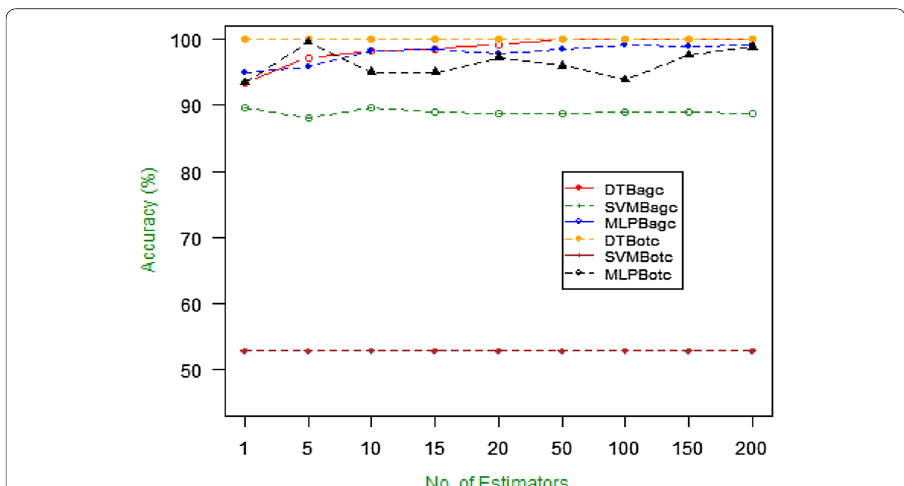
Fig. 6 Bagging and boosting classifiers accuracy over the GSE dataset